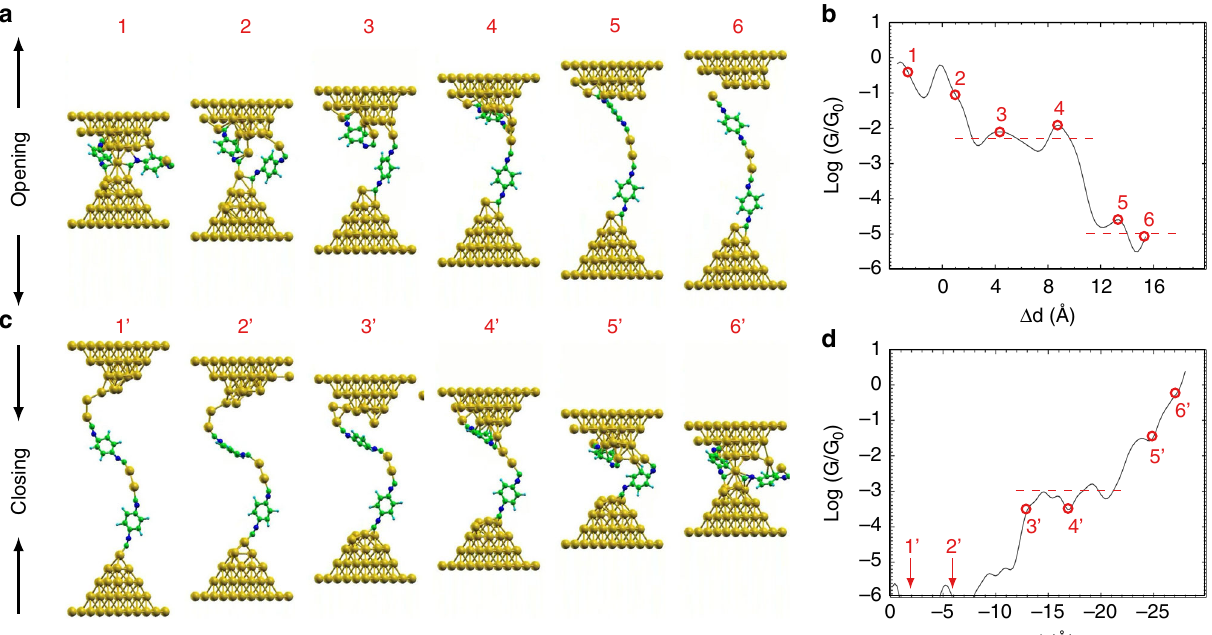
Fig. 2 Molecular dynamics simulation demonstrating chaining mechanism. a , c Snapshots of the molecular dynamics simulations for the opening and the closing of the BdNC molecular junction, respectively, demonstrating the chaining effect in presence of extra BdNC molecule. b , d Reconstructed conductance traces along the corresponding DFT-MD trajectories. Numbered points correspond to the snapshots in ( a , c